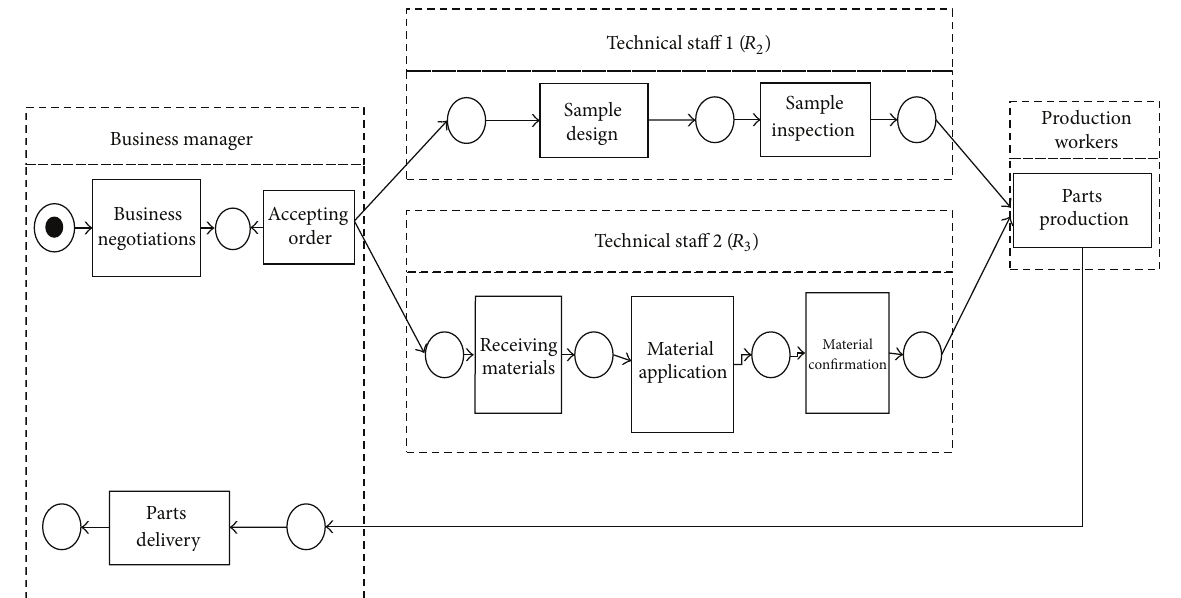
Figure 1: The mined role-activity diagram.